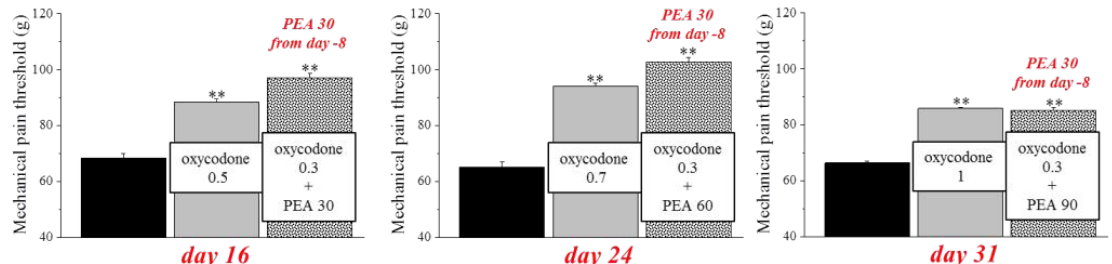
Figure 5. Antinociceptive effects of different combinations of oxycodone and PEA. Animals were treated with the vehicle (Groups a and b) or pre-emptive PEA (30 mg kg − 1 in the evening; Group c) per os daily for the duration of the experiment, starting on Day − 8. To maintain a pain threshold of about 90 ± 10 g, beginning on Day 1, increasing daily doses of oxycodone (0.3–1 mg kg − 1 ) were injected s.c. to Group b. Different combinations of oxycodone (0.3 mg kg − 1 , s.c.) and PEA (30–90 mg kg − 1 , p.o.) were administered to Group c. Measurements were conducted every day in the morning, before and 30 min after oxycodone and/or acute PEA administration. Representative results obtained 30 min after treatments on Days 1, 4, 9, 16, 24 and 31 are shown. The results are expressed as mean ± SEM of values from 12 rats analysed in two different experimental sets. Statistical analysis was one-way ANOVA followed by Bonferroni’s post hoc comparison. ** p < 0.01 vs. vehicle + vehicle group.